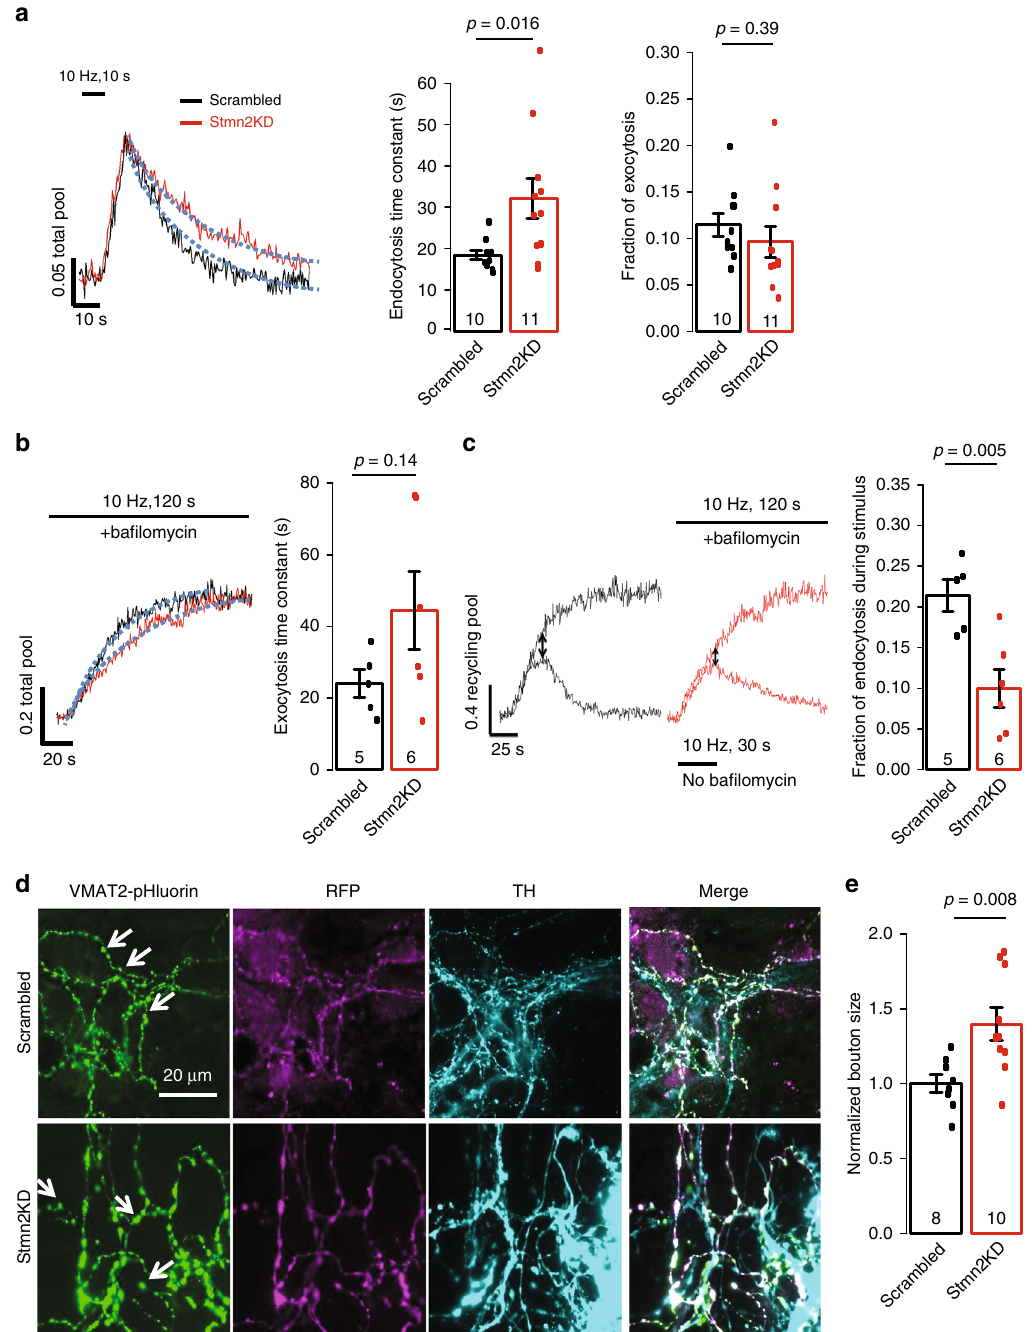
Fig. 3 pHluorin assay in cultured DA neurons with Stmn2 knockdown. a SV endocytosis and exocytic fraction in midbrain DA neurons with or without Stmn2 knockdown. Two-sided Student ’ s t test for two-group comparison. t = − 2.6572, df = 19, p -value = 0.01556 for endocytosis time constant, which is the τ of the fi tted one-phase exponential decay indicated by the blue dash line; t = 0.87198, df = 19, p = 0.3941 for exocytic fraction, which is the normalized peak height. b SV exocytosis in midbrain DA neurons with or without Stmn2 knockdown. The exocytosis time constant is the τ of the fi tted one- phase exponential decay indicated by the blue dash line. This is a subset of neurons recorded in ( a ). Two-sided Student ’ s t test for two group comparison. t = − 1.6213, df = 9, p -value = 0.1394. c SV endocytosis during stimulation in midbrain DA neurons with or without Stmn2 knockdown as indicated by the arrows in c . This is a subset of neurons recorded in ( a ) and the same neurons in ( b ). Two-sided Student ’ s t test for two group comparison. t = 3.6414, df = 9, p -value = 0.005389. N indicated in each experiment. d Immunostaining of VMAT2-pHluorin, RFP tag of Stmn2-shRNA plasmid, and TH of recorded DA neurons treated with scrambled or Stmn2 -shRNA. Arrows pointed to representative boutons. e Quanti fi cation of bouton sizes in scrambled and Stmn2 - shRNA-treated TH + neurons. Two-sided Student ’ s t test for two group comparison. t = 3.2224, df = 16, p -value = 0.008433. All data are present as mean ± SEM. Source data are provided as a Source Data fi